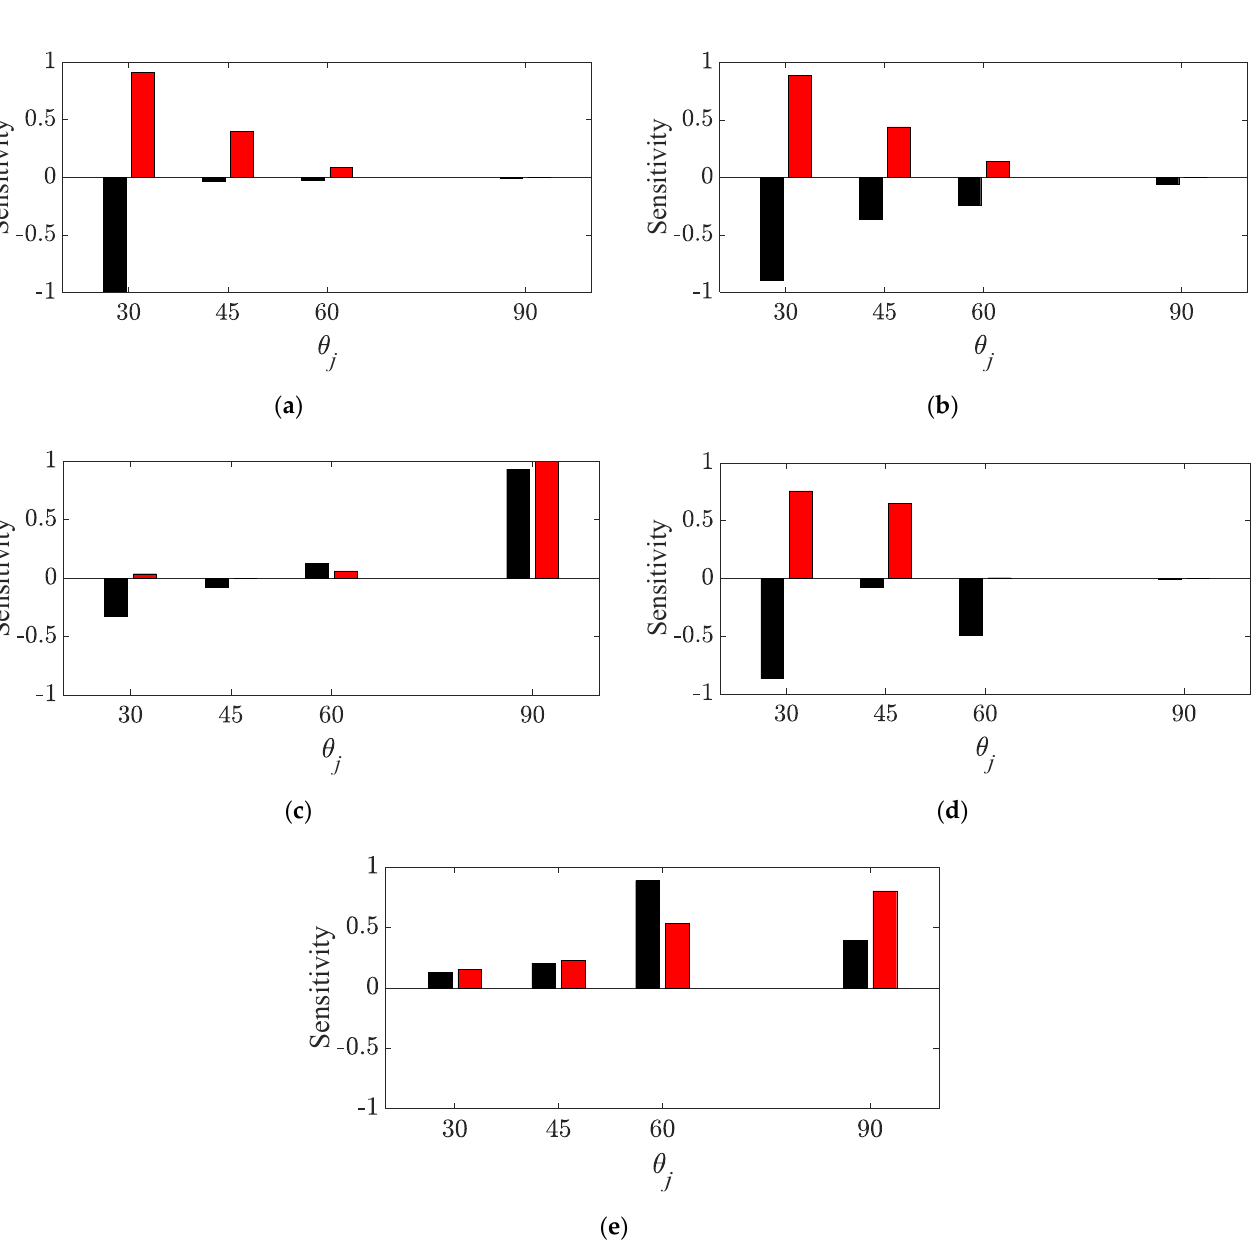
Figure 6. Sensitivity analysis results, : the mass-normalized equivalent structural stiffness, : the structural stiffness ratio between the θ l carbon fiber angle and the reference one. ( a ) First mode (first bending); ( b ) second mode; (first twisting); ( c ) third mode (second twisting); ( d ) fourth mode (second bending); ( e ) fifth mode (third bending).